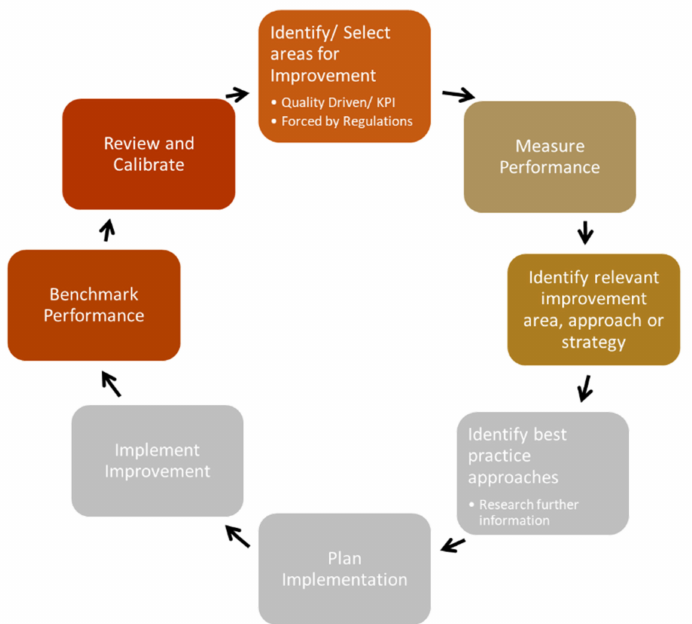
Figure 1. The Improvement Cycle for decreased CO 2 Emissions and increased Energy Efficiency. This paper focuses on the upper half of the